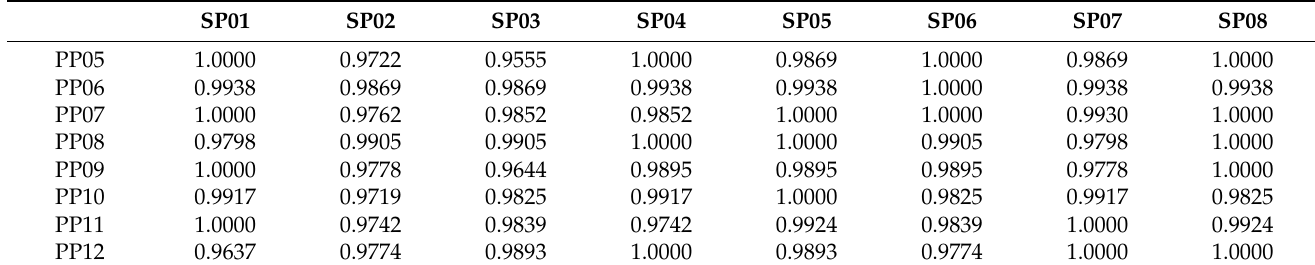
Table 6. Final ranking score.